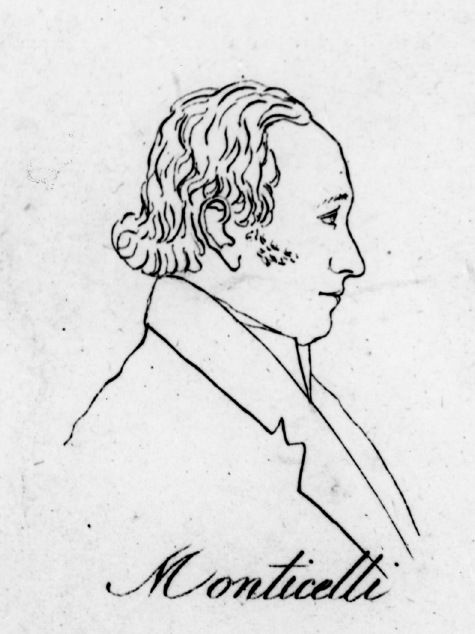
Fig. 4. Portrait of Teodoro Monticelli, secretary of the Academy of Science in Naples, taken by Gio- vambattista Amici with his «camera lucida» in 1817 during his stay in Naples (Biblioteca Estense di Modena, Fondo Amici, donazione